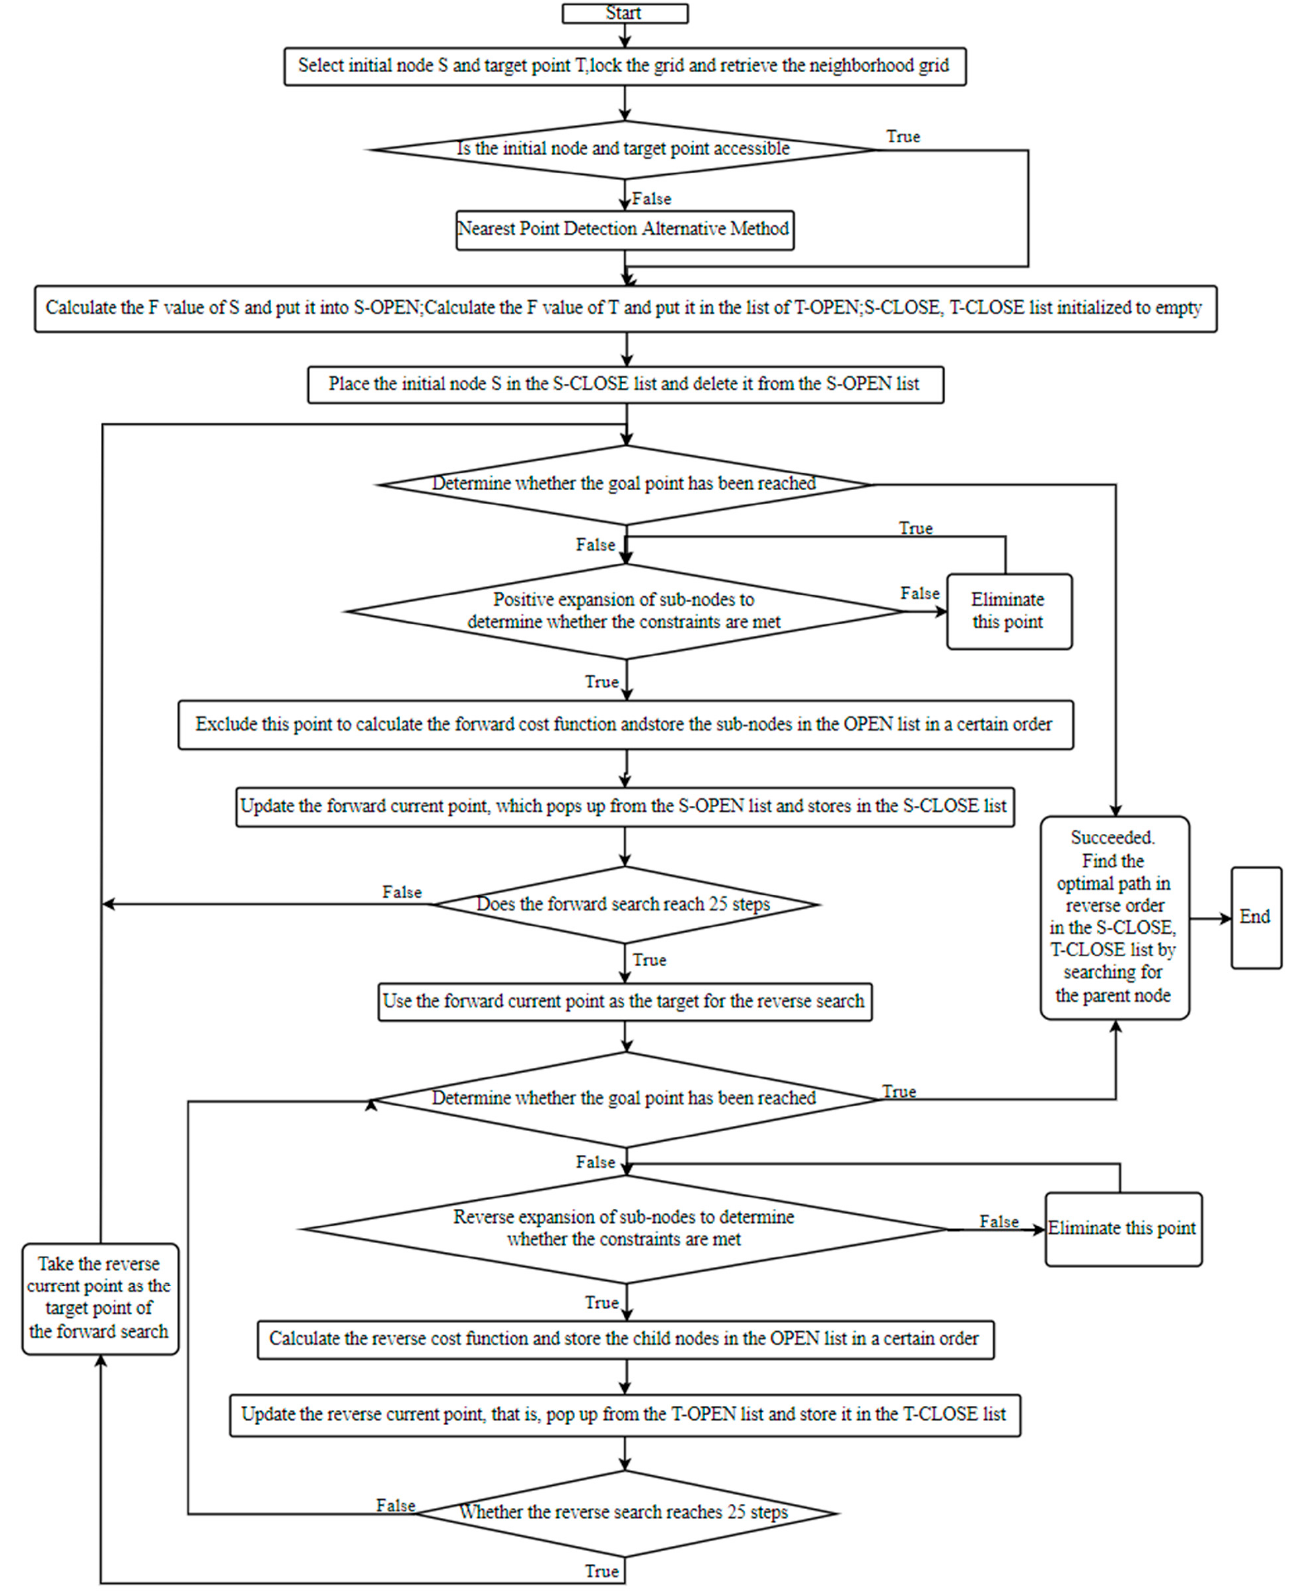
Figure 6. Flow chart of an improved A* algorithm.